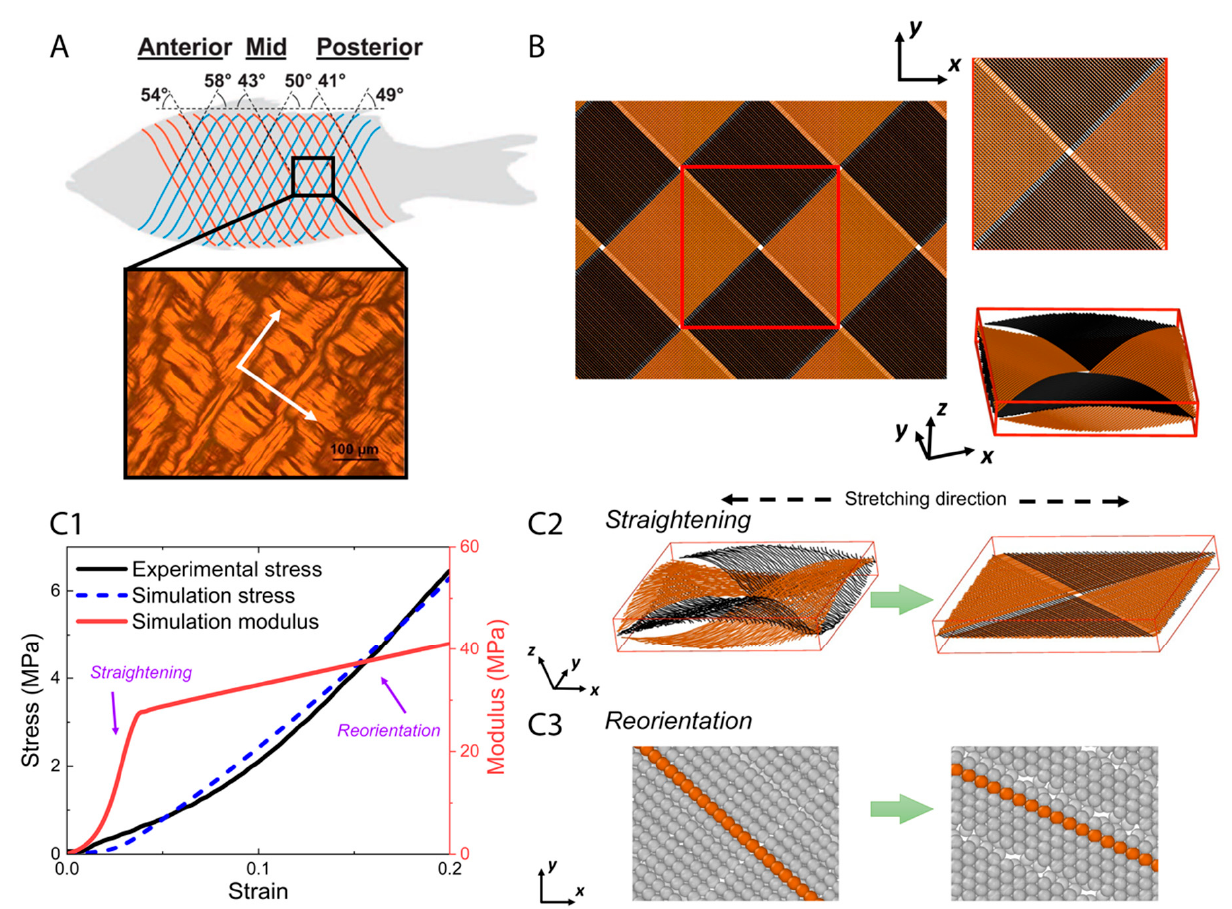
Figure 4. The orthogonal-cross-ply structure of collagen microfibers in fish skin (Reproduced with permission from reference [5]; Copyright 2017 Elsevier) where white arrows indicate the orientations of microfibers in the structure ( A ), geometry setting of agent-based model ( B ), and tensile test results in simulation ( C1 – C3 ). ( A ) The periodic microfibers have two orthogonal principal directions. A corresponding representative volume element was generated ( B ), and then tensile test was applied. The stress–strain curve and modulus as a function of strain, from experimental and simulation ( C1 ), show a two-step stretching process. Two primary movements, straightening ( C2 ) and reorientation ( C3 ) of the microfibers, dominate the tensile response successively, which together elucidate the mechanism underlying strain-stiffening behavior of fish